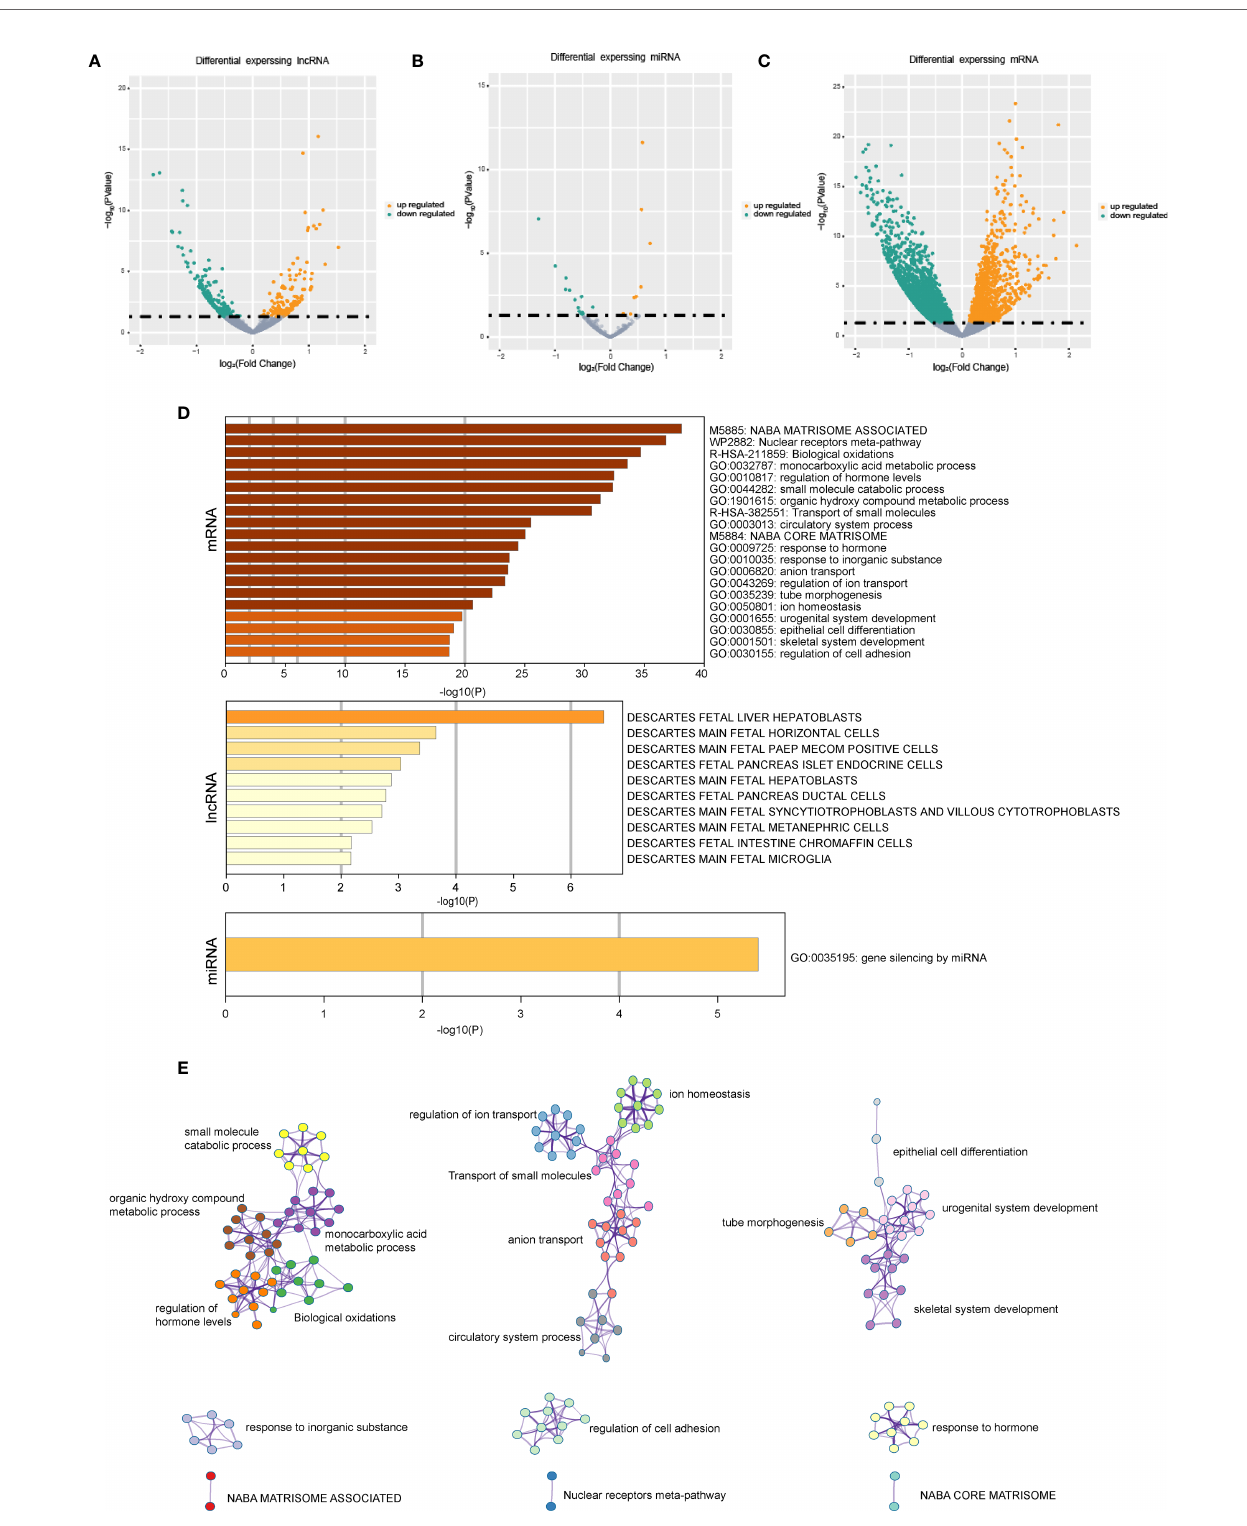
FIGURE 2 | The gene expression difference in the senescence-related HCC subtypes. (A) The volcano plots of differential expressed lncRNAs in the two HCC subtypes. (B) The volcano plots of differential expressed miRNAs in the two HCC subtypes. (C) The volcano plots of differential expressed mRNAs in the two HCC subtypes. (D) Enrichment analysis based on differentially expressed genes. (E) Network of the differential expressed mRNAs ’ signi fi cantly enriched